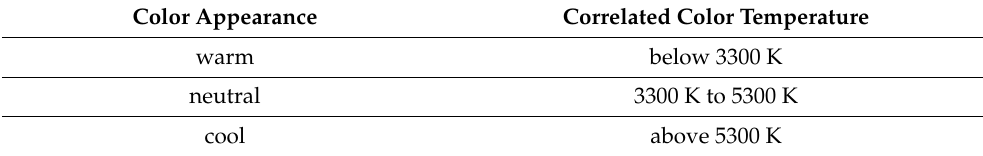
Table 3. Correlated color temperature